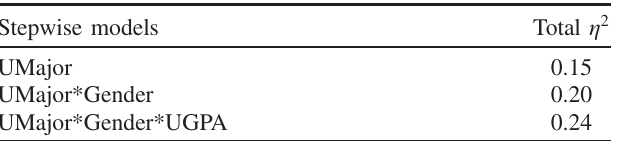
TABLE I. Stepwise linear regression models including top examinee characteristics most strongly associated with perfor- mance on the Praxis physics subject assessment from 2006 to